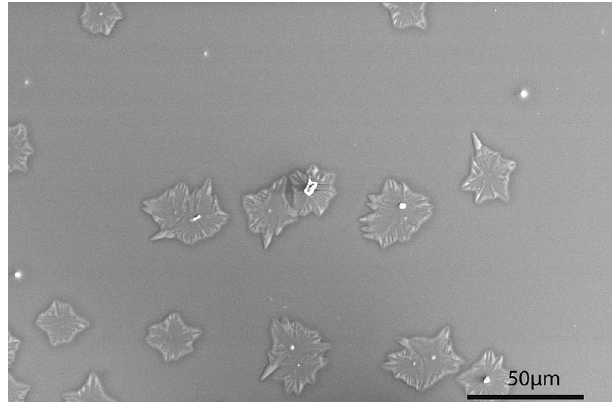
Figure 9. SEM image of a Si 0.08 Ge 0.92 O 2 film on sapphire substrates showing that some crystals are formed on the thin